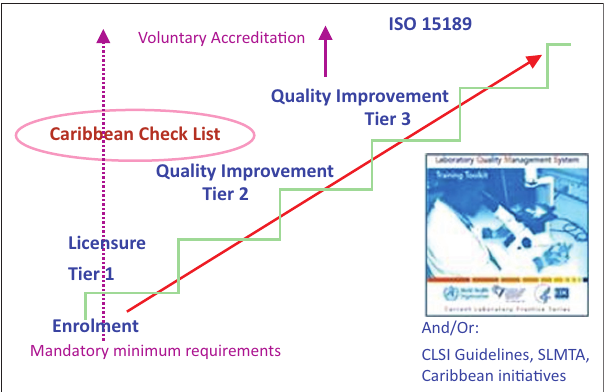
FIGURE 2: Caribbean Laboratory Quality Management Systems Stepwise Improvement Process showing the stepwise levels of recognition of laboratories at enrolment and following quality